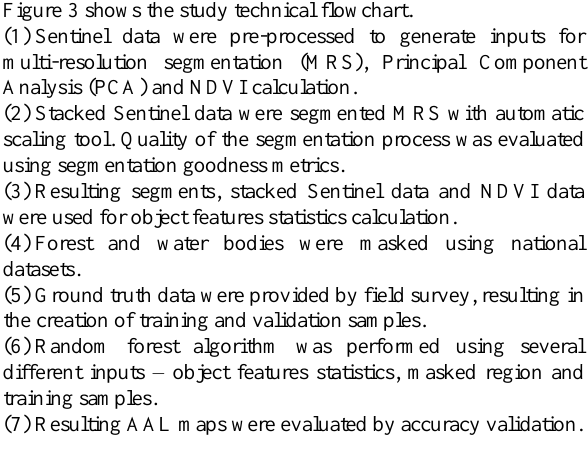
Figure 1. Location of the study area